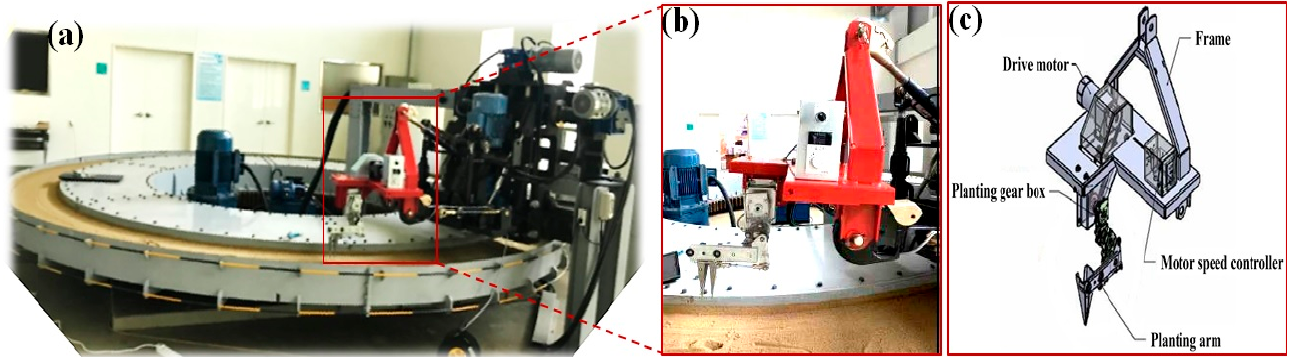
Figure 4. Experimental test bench layout with planting device at RDA, Jeonju, Korea: ( a ) test bench, ( b ) planting device, and ( c ) planting device with its all components.